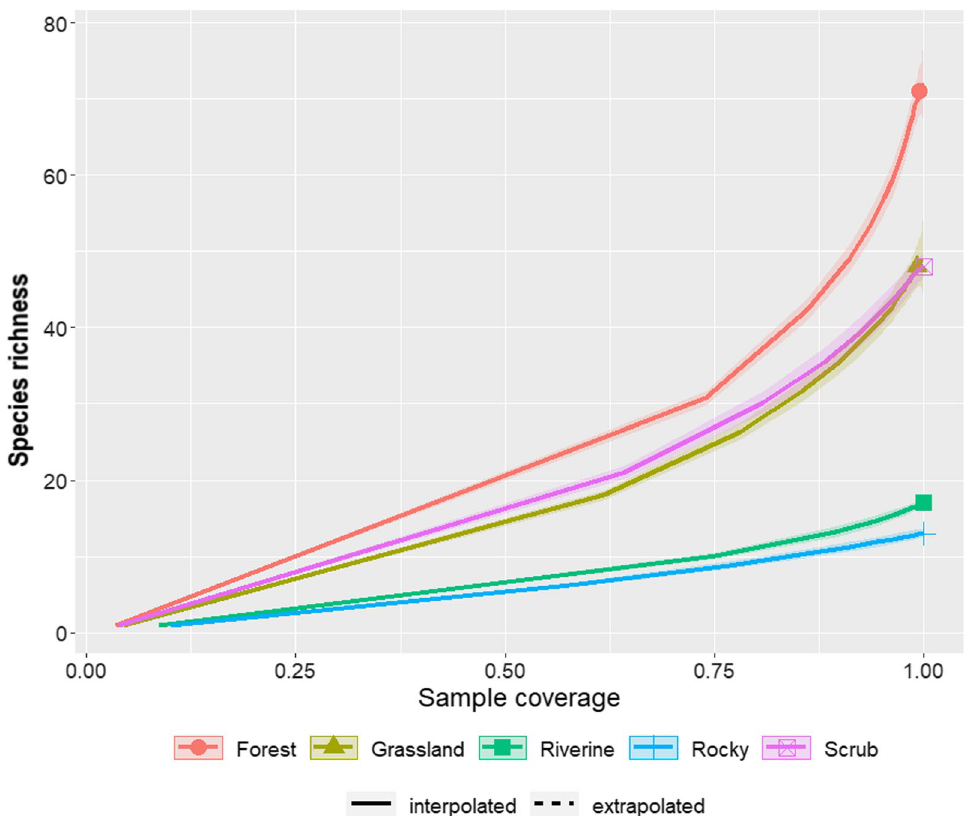
Fig. 4 Coverage-based rarefaction and extrapolation curves of bird species for the studied vegetation or land use types. The shaded areas are the 95% confidence intervals of species richness